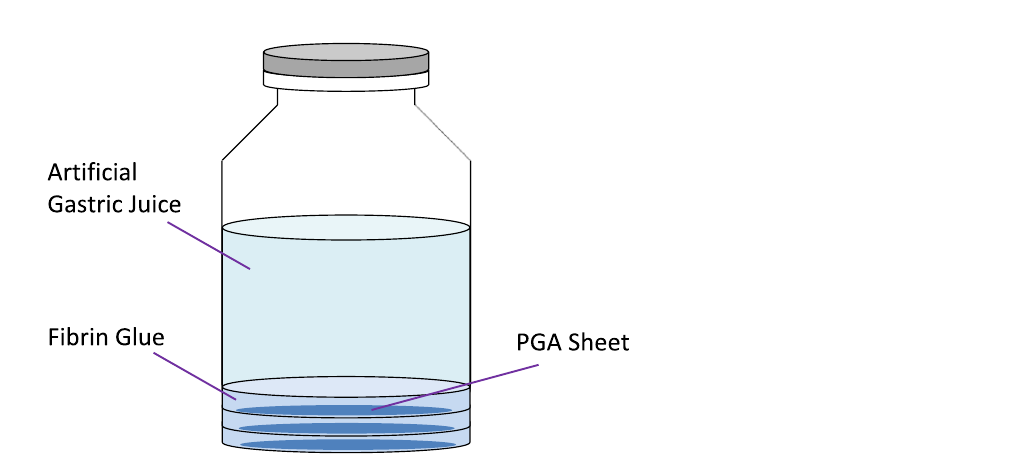
Figure 1. The pH stability and pH activity of pepsin. Quoted from Piper DW, Fenton BH. pH stability and activity curves of pepsin with special reference to their clinical importance.